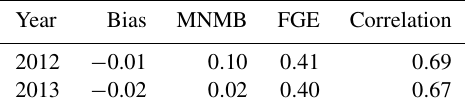
Table 4. Mean statistics of the comparison between the AERONET AOD data and the MOCAGE simulation for the years 2012 and 2013. See Appendix A for information about statistical